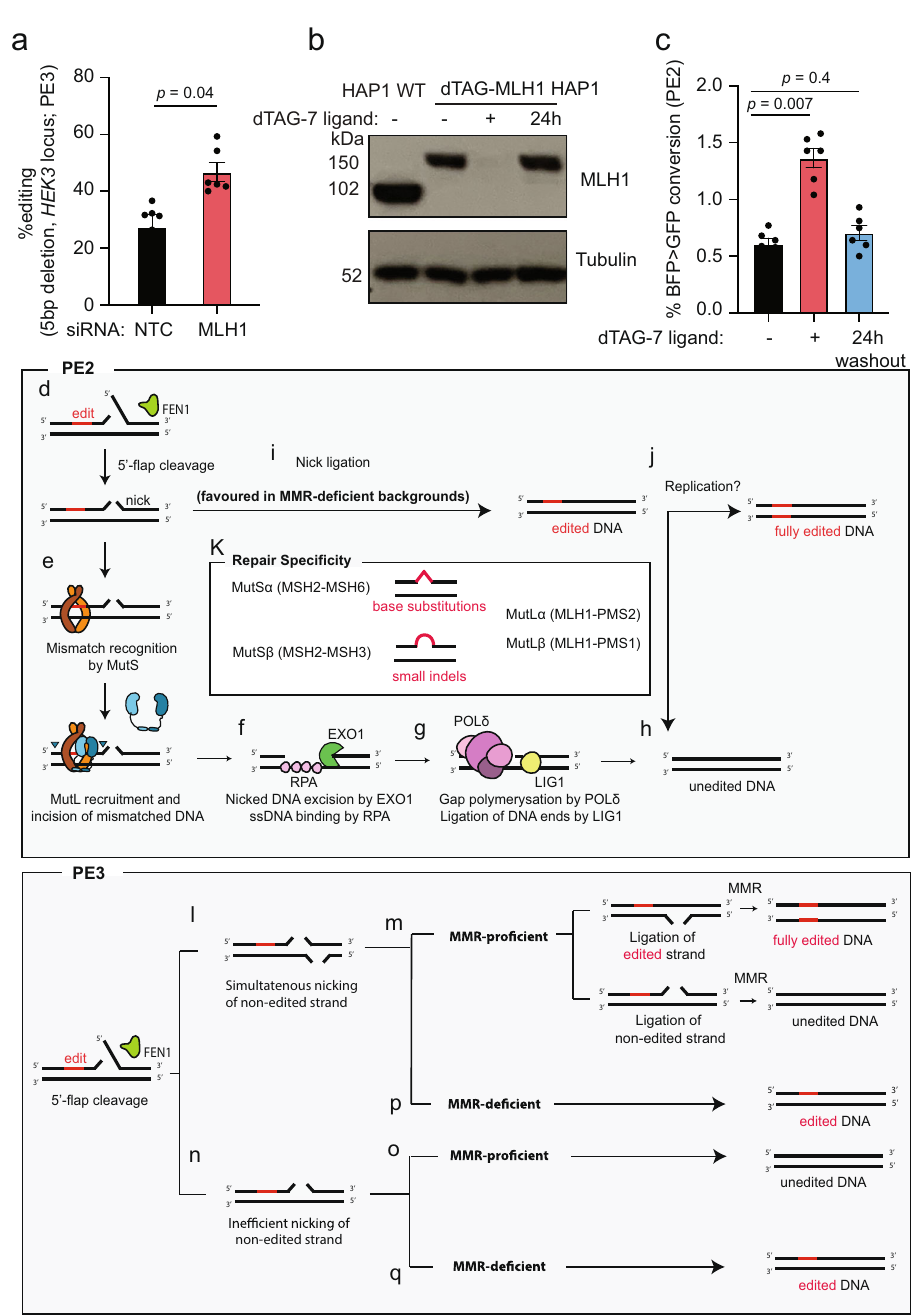
Fig. 3 Reversible ablation of MLH1 can be exploited to increase prime editing ef fi ciency. a PE ef fi ciency of a 5 bp deletion ( HEK3 locus) in HEK293 cells transfected with non-targeting control (NTC) or MLH1 siRNA pools. Editing ef fi ciency measured by Sanger sequencing and TIDE analysis, for n = 3 biologically independent experiments (technical replicates also depicted). b Immunoblot for MLH1 and Tubulin in HAP1 cell extracts with ( ‘ + ’ ) or without ( ‘ − ’ ) dTAG-7 ligand. Recovery of dTAG-MLH1 expression was measured 24 h after ligand removal ( ‘ 24 h ’ ). n = 2 biologically independent experiments.